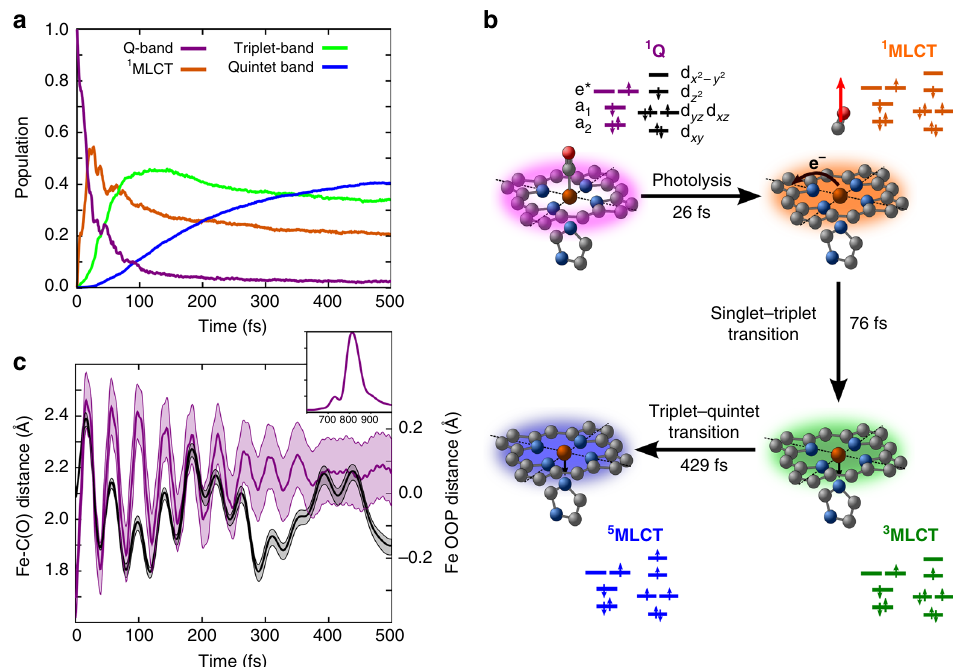
Fig. 1 Photodynamics of photolysis and spin-crossover. Quantum photodynamics of heme – CO complex during the fi rst 0.5 ps, with initial conditions averaged over 10 molecular dynamics snapshots. a Evolution of diabatic populations for states 1 Q (magenta), 1 MLCT (orange), triplet band (green) and quintet band (blue). The 1 Q population rapidly decays giving rise to 1 MLCT population dominating by 75 fs, at which point the triplet population increases. The quintet population builds up more slowly, and evolves into the dominant state at around 350 fs. b Schematic representation of the reaction mechanism and interpretation in terms of time constants. Upon initial excitation to the Q-band, the metal-to-ligand charge transfer (MLCT) state is populated in ∼ 25 fs. In a second step, the system relaxes to the triplet ( ∼ 75 fs) and to the lowest quintet state ( ∼ 430 fs). Black arrows indicate the direction of the electron transfer and the main nuclear motions. c Evolution of the Fe – C(O) distance (magenta, left axis) and the Fe out-of-plane distance (black, right axis). Large amplitude motions are observed with a period of oscillation of 40 fs. The amplitude of oscillation is initially 0.9 Å and converges towards a value of 2.2 Å. At this distance, the CO is essentially photolyzed. The standard deviation of these geometric values is shown as a shaded area. In the inset, the Fourier transform of the Fe – C(O) oscillations is shown (in cm − 1 )